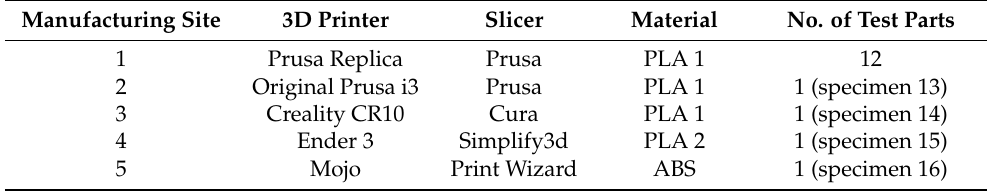
Table 2. Test parts built in different manufacturing sites.